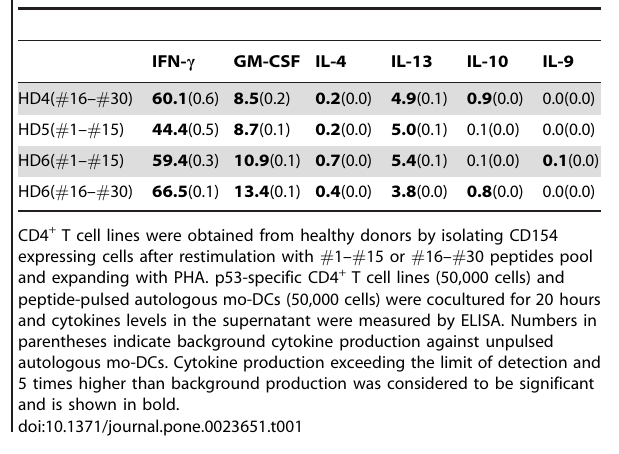
Table 1. Cytokine levels (ng/ml) in supernatant of isolated and expanded p53-specific CD4 + T cell lines of healthy